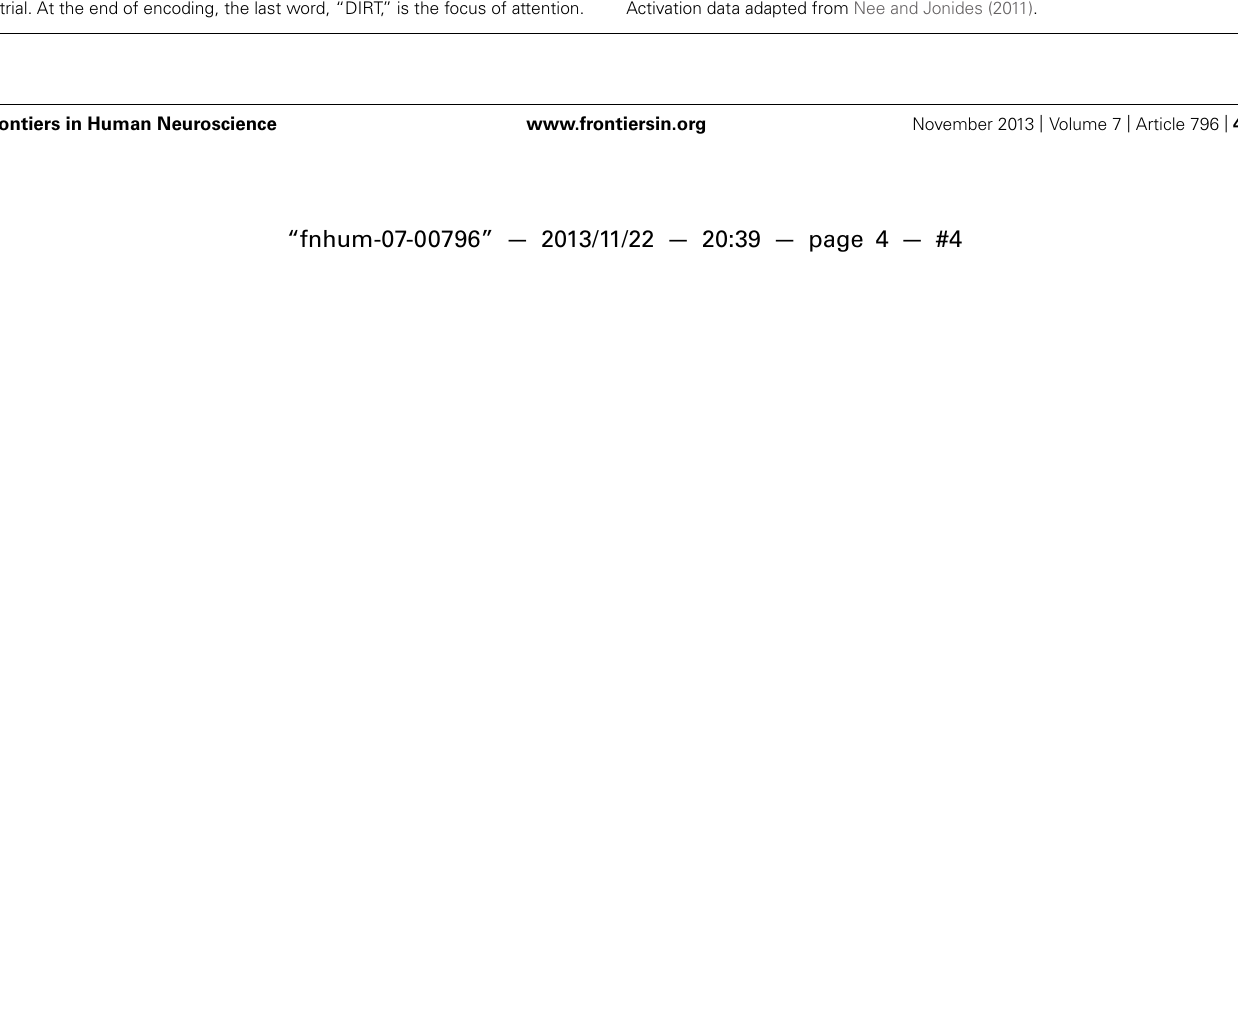
FIGURE 2 |Assessing representational states via serial positions. Illustration of the task used by Nee and Jonides (2008) to dissociate the focus of attention from the direct-access region.Three words are sequentially presented followed by a mask and a recognition probe.Timing information depicts the onset of each stimulus relative to the start of the trial. As each memorandum is presented, it is assumed that it becomes the focus of attention.Thus, upon presentation of “TOOL,” “TOOL” is the focus of attention.When “LAKE” is presented, the focus of attention switches to “LAKE.” As each item is presented, it is bound to the temporal context of the trial. At the end of encoding, the last word, “DIRT,” is the focus of attention.